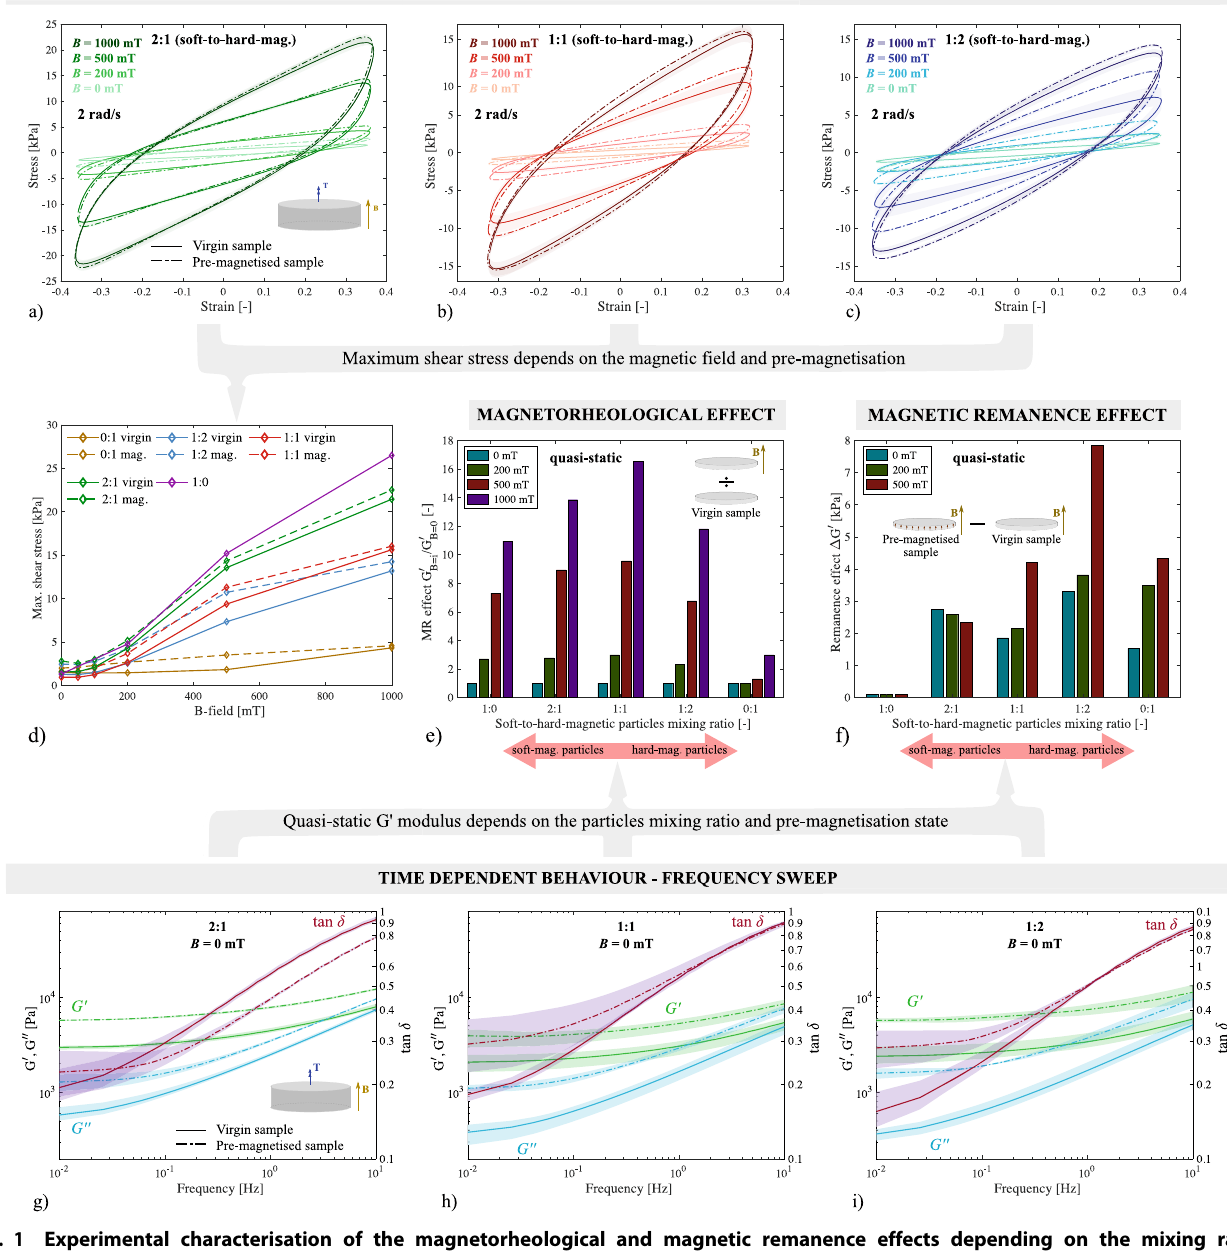
Fig. 1 Experimental characterisation of the magnetorheological and magnetic remanence effects depending on the mixing ratio between soft- and hard-magnetic particles. Results from constant oscillatory shear loops for soft-to-hard-magnetic particles mixing ratios of a 2:1, b 1:1 and c 1:2. The total amount of particles is 30 vol.%. The experiments are performed on both virgin and pre-magnetised samples (i.e., previously exposed to 1000 mT axial magnetic fi eld). d Maximum shear stress reached during the constant oscillatory shear tests depending on the magnetic fi eld applied, and for different particles' mixing ratios. The solid lines denote experimental results on virgin samples and dashed lines denote experimental results on pre-magnetised samples. e Magnetorheological effect, i.e., the ratio between the storage shear moduli under magnetic actuation and under null magnetic actuation, for different hybrid MREs. d Magnetic remanence effect, i.e., the difference between the storage shear moduli of pre-magnetised and virgin samples, for different hybrid MREs and different applied magnetic fi elds. g – i Frequency sweep tests under shear loading and null magnetic actuation on virgin (solid lines) and pre-magnetised (dash lines) hybrid MREs with mixing ratios of 2:1, 1:1 and 1:2, respectively. These results are presented in terms of storage ( G ') and loss ( G '') moduli, and loss factor ( tan δ